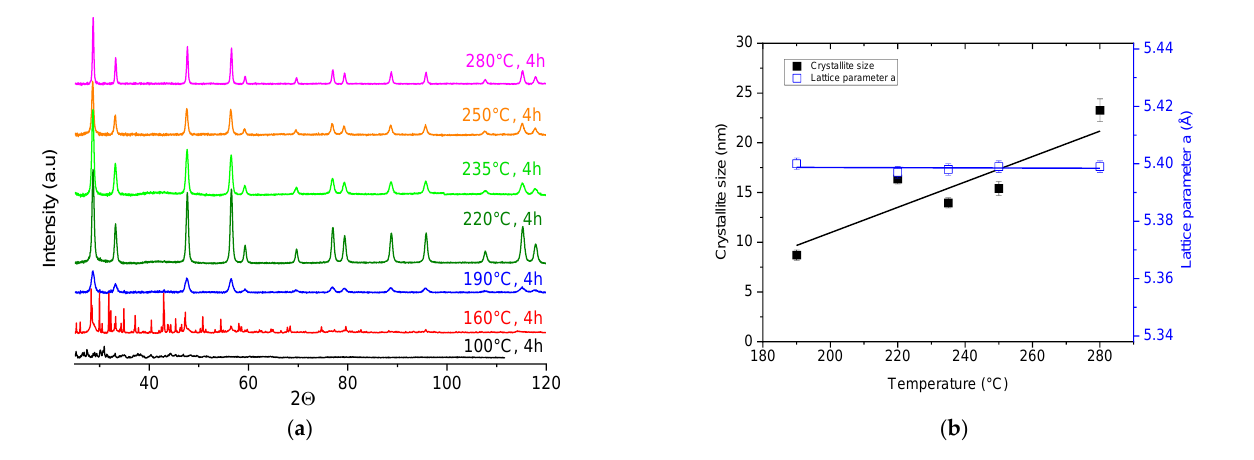
Figure 1. ( a ) Evolution of XRD patterns obtained for samples by hydrothermal decomposition of Pu(C 2 O 4 ) 2 .6H 2 O in the temperature range from 100 °C to 280 °C for 4 h. Note that under the selected conditions, PuO 2 forms in pure phase above 190 °C; ( b ) variation in the crystallite size and lattice parameter a of PuO 2 as a function of temperature.